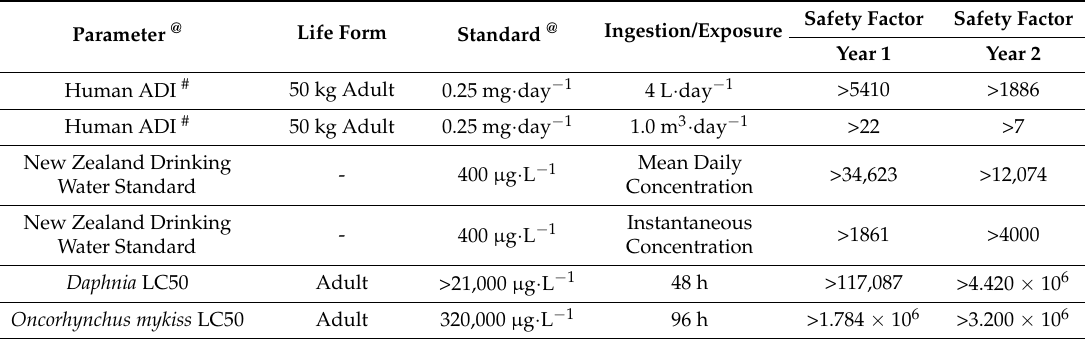
Table 4. Hexazinone toxicological parameters and modeled safety factors for Years 1 and 2.